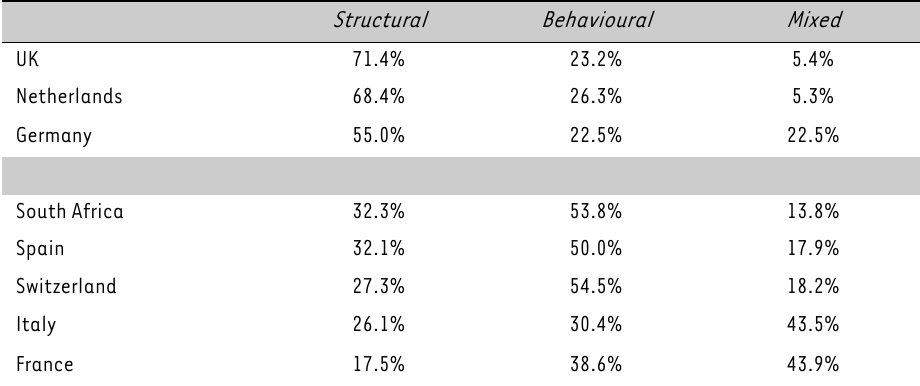
TABLE 1: Merger remedies in selected European countries and South Africa, 2000–2008 Structural Behavioural